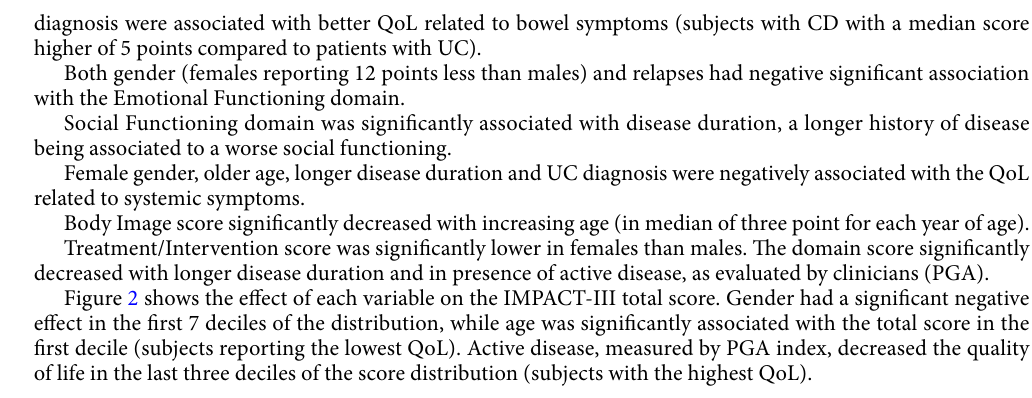
Figure 2. Effects of different variables on the IMPACT-III total score. The x-axis indicates the 9 deciles of the response distribution (score) and y-axis exhibits the effect of each variable (regression coefficients) and 95% confidence bands (grey area). If the confidence interval includes 0, the estimates cannot be considered statistically different from